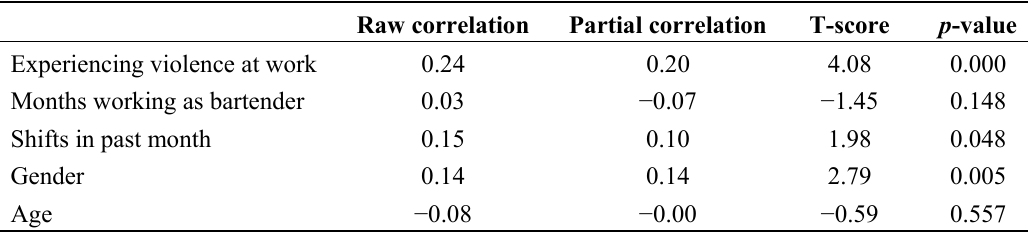
Table 2. Predictors of higher scores on